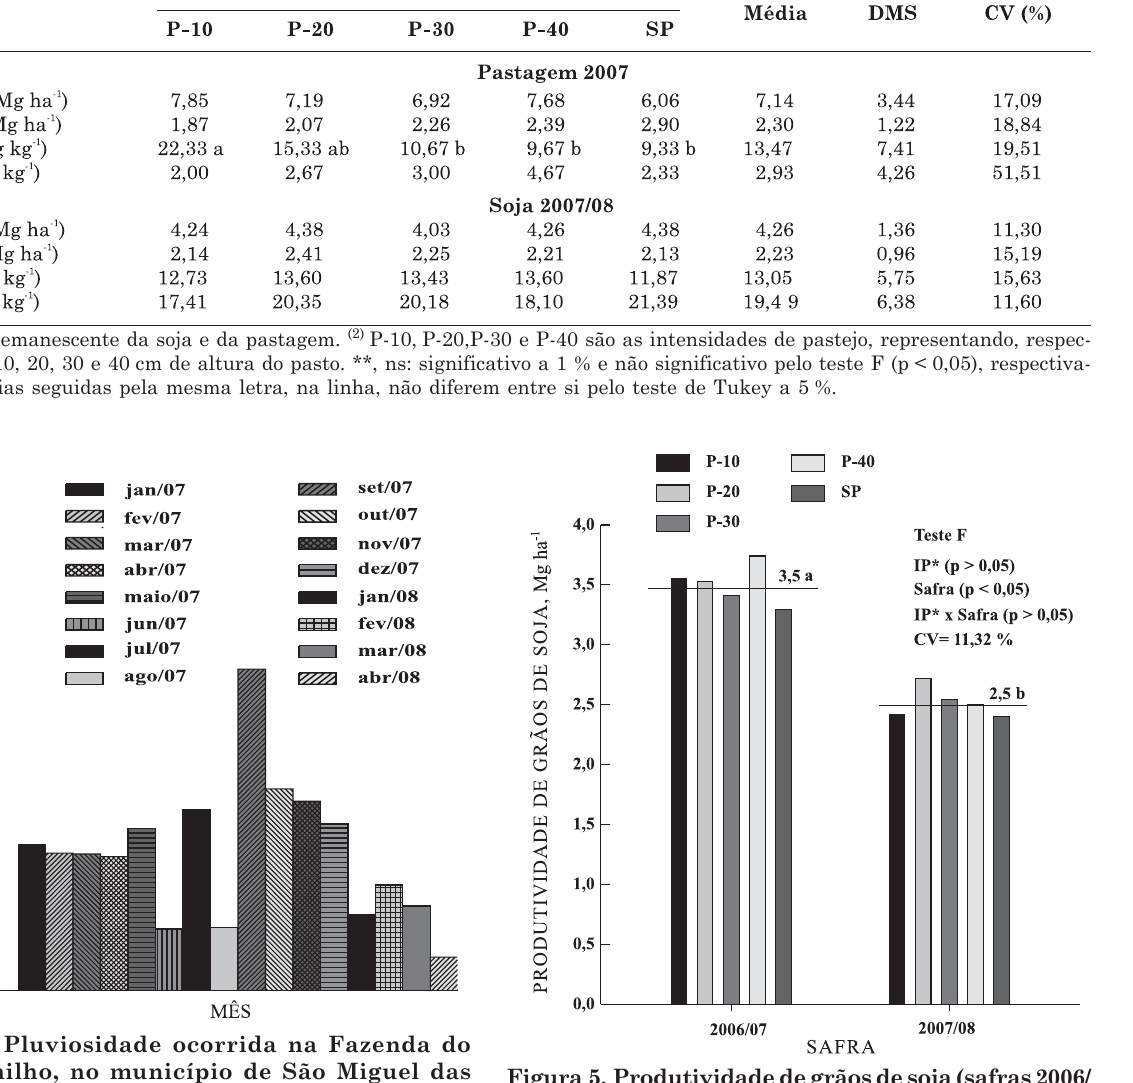
Figura 5. Produtividade de grãos de soja (safras 2006/ 07 e 2007/08) em sistema de integração lavoura- pecuária submetido a intensidades de pastejo (10, 20, 30 e 40 cm de altura do pasto - P-10, P-20, P-30 e P-40, respectivamente) e sem pastejo (SP). *Intensidade de pastejo. Médias seguidas por letras diferentes diferem entre si pelo teste de Tukey a 5